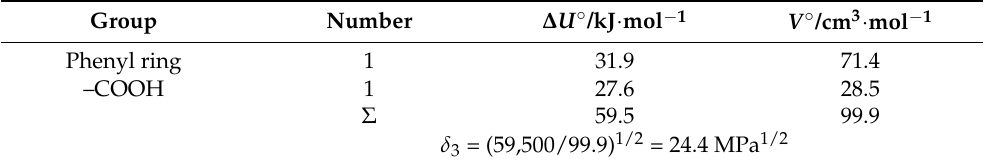
Table 3. Internal energy, molar volume, and Hildebrand solubility parameter of benzoic acid calcu- lated according to the Fedors